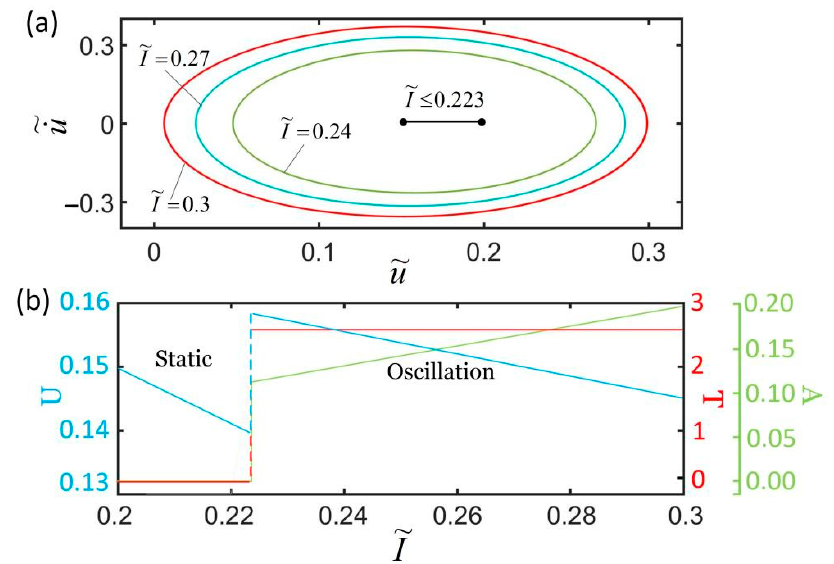
8.5~ 28.0~ = = k c , 3.0 =α Figure 10. The effect of light intensity on self-excited oscillation for (cid:101) k = 5.8, (cid:101) c = 0.28, α = 0.3, (cid:101) g = 1.2, Figure 10. The effect of light intensity on self-excited oscillation for , 1.1~ 0~ . 0~ 2.1~ = = u = L = u  u 0 = 0. ( a ) Limit cycles; ( b ) amplitude, period, and equilibrium position. There g , (cid:101) L p = 1.1, (cid:101) u 0 = 0, and (cid:101) , , , and . ( a ) Limit cycles; ( b ) amplitude, period, and equilib- 0 p 0 exists a critical light intensity (cid:101) I = 0.223 for triggering self-excited 223.0~ = I rium position. There exists a critical light intensity